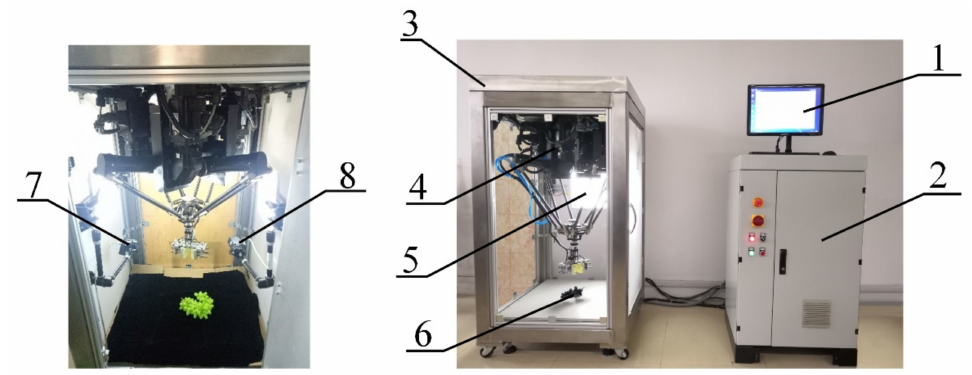
Figure 10. Prototype of automatic sorting system for stacked fruit clusters based on a 4 − R(2 − SS) parallel robot and machine vision. (1) Display screen; (2) control cabinet; (3) detection cabinet; (4) parallel robot; (5) light source; (6) fruit cluster; (7) left camera; (8) right